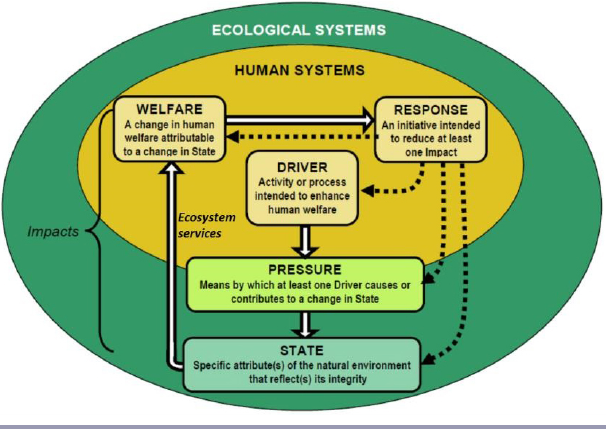
Fig. 4 . The Driver Pressure State Welfare Response framework developed in KnowSeas, and the basis of further research (based on Cooper